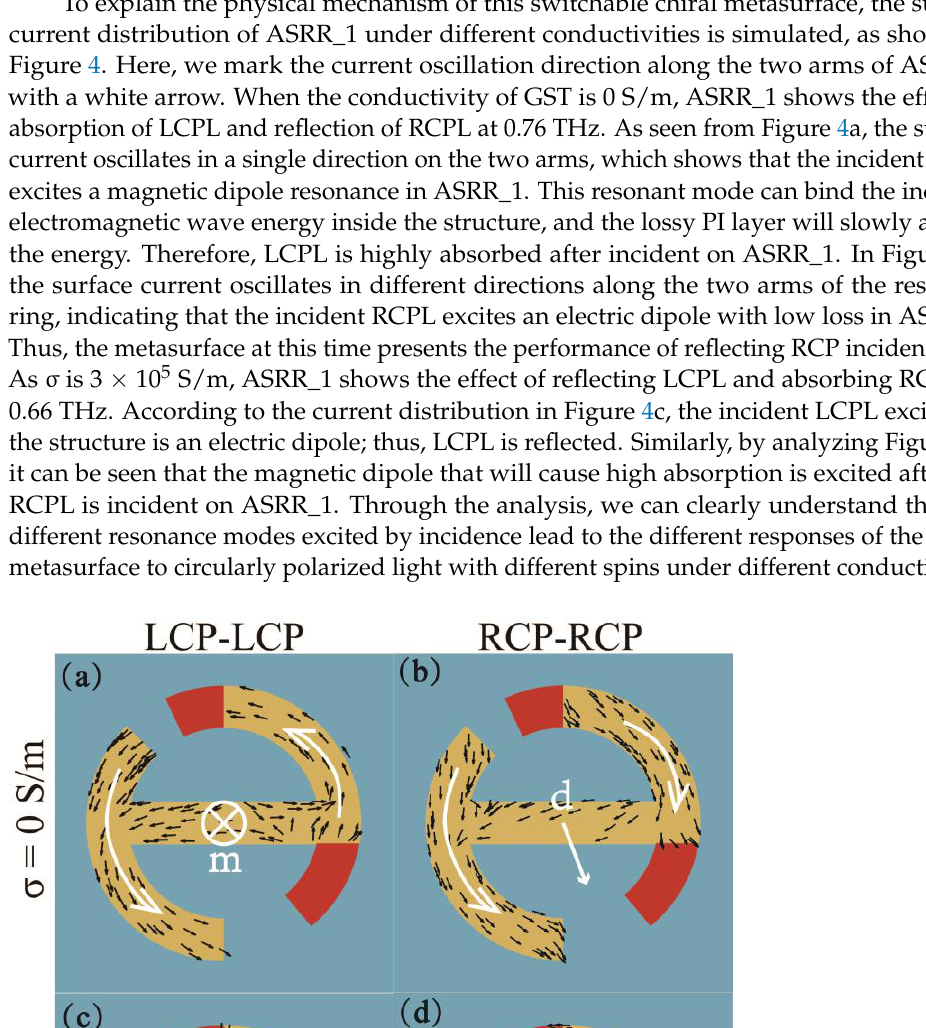
Figure 3. Reflection spectra of ASRR_1 with different conductivities of GST.